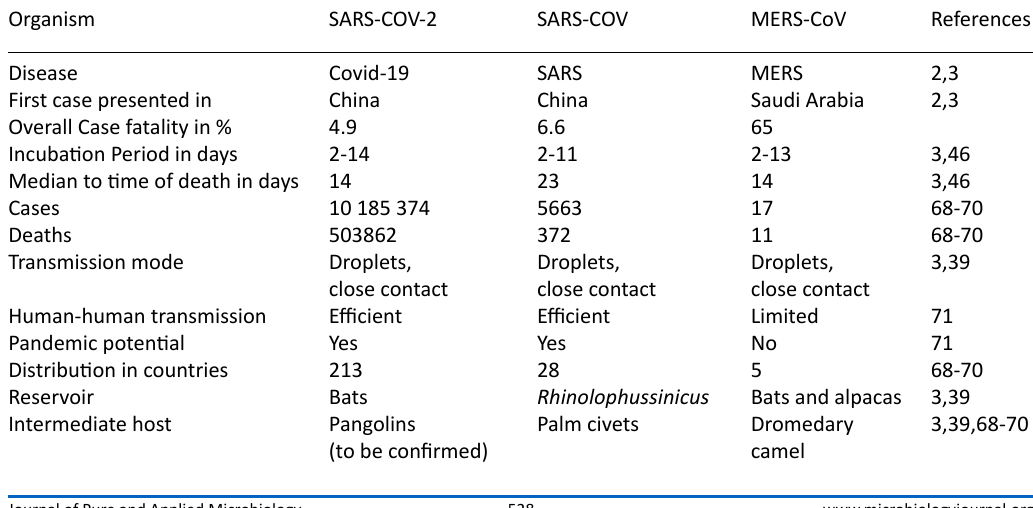
Table 3. The first six months of COV1D-19, MERS and SARS disease outbreaks Organism SARS-COV-2 SARS-COV MERS-CoV Disease Covid-19 SARS MERS 2,3 First case presented in China China Overall Case fatality in % 4.9 Incubation Period in days Median to time of death in days Cases Deaths 503862 Transmission mode Droplets, Droplets, Droplets, close contact close contact close contact Human-human transmission Efficient Efficient Limited Pandemic potential Yes Distribution in countries Reservoir Bats Intermediate host